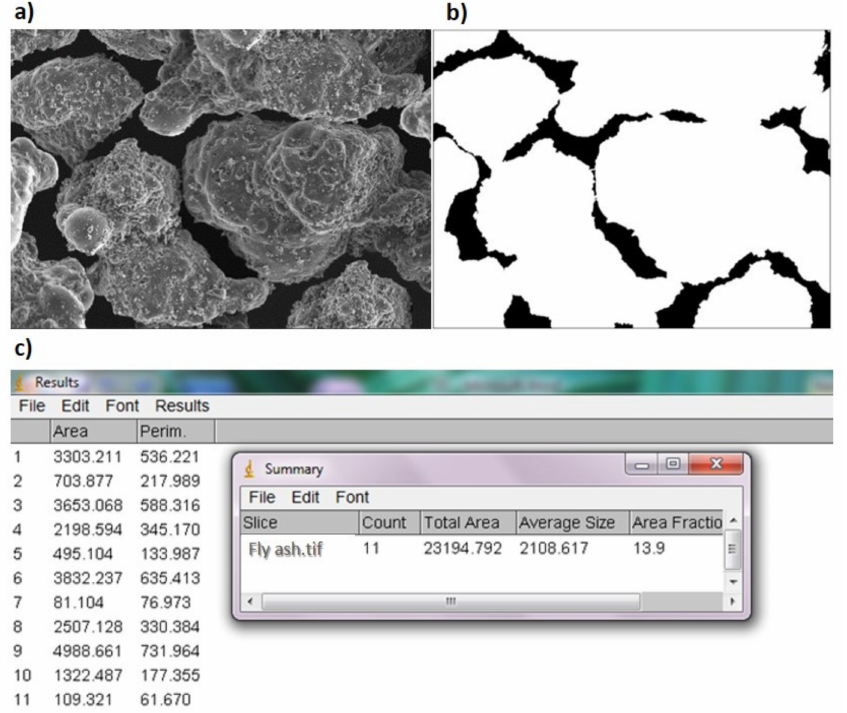
Figure 6. Analysis of the pore space of a single image using ImageJ software on example of fly ash: ( a ) output image; ( b ) image after transformations; ( c ) geometric pore parameters.